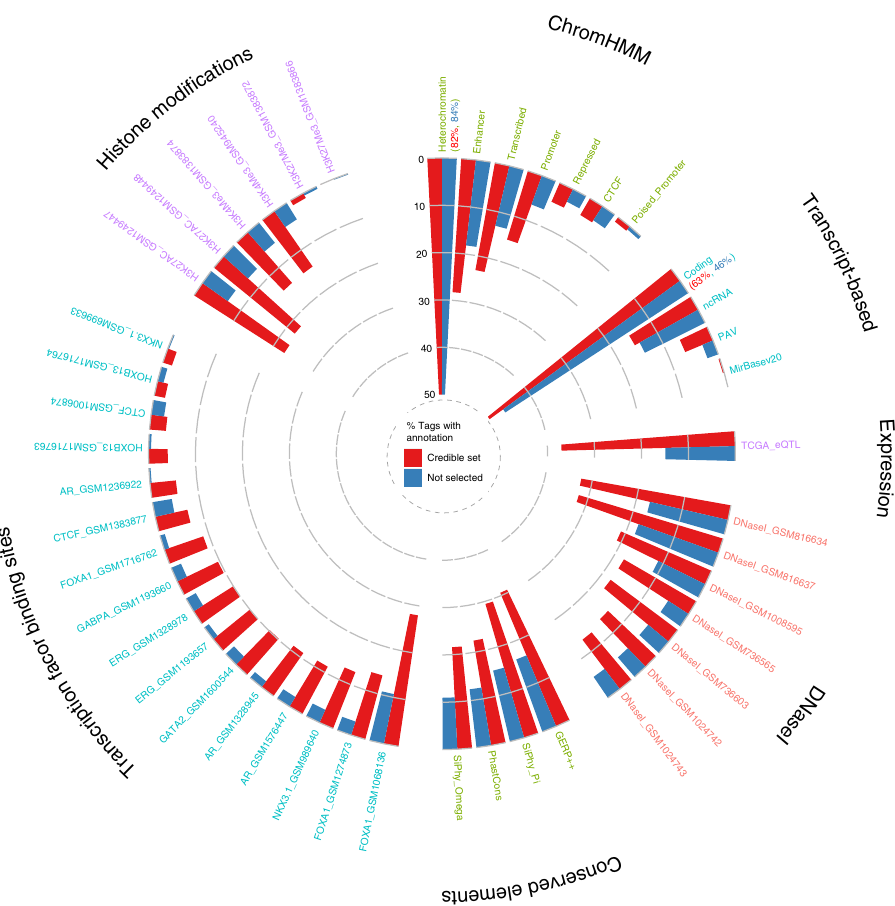
Fig. 2 Polar bar plot depicting the proportion of tag variants assigned each functional annotation within the 95% credible set selected by JAM (red bars), relative to tags that were not selected as candidates during fi ne-mapping (blue bars). Binary annotations for all respective proxy variants were inherited by their tag. Annotations are grouped by category and ordered according to the proportion of variants in the credible set that receive each speci fi c annotation. For greater clarity at lower values the plot axis is capped at 50%, therefore for annotation classes that exceed this limit (Heterochromatin and Coding) the total percentage of tags receiving the annotation is speci fi ed in